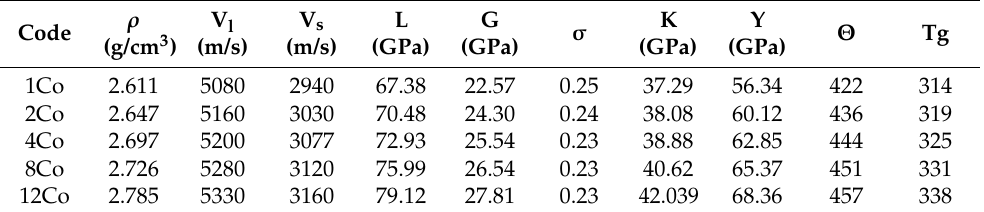
Table 3. Density, longitudinal velocity (V l ), shear velocity (V S ), longitudinal modulus (L), shear modulus (G), bulk modulus (K), Young’s modulus, Poisson’s ratio, Debye temperature, and Tg of the glasses.